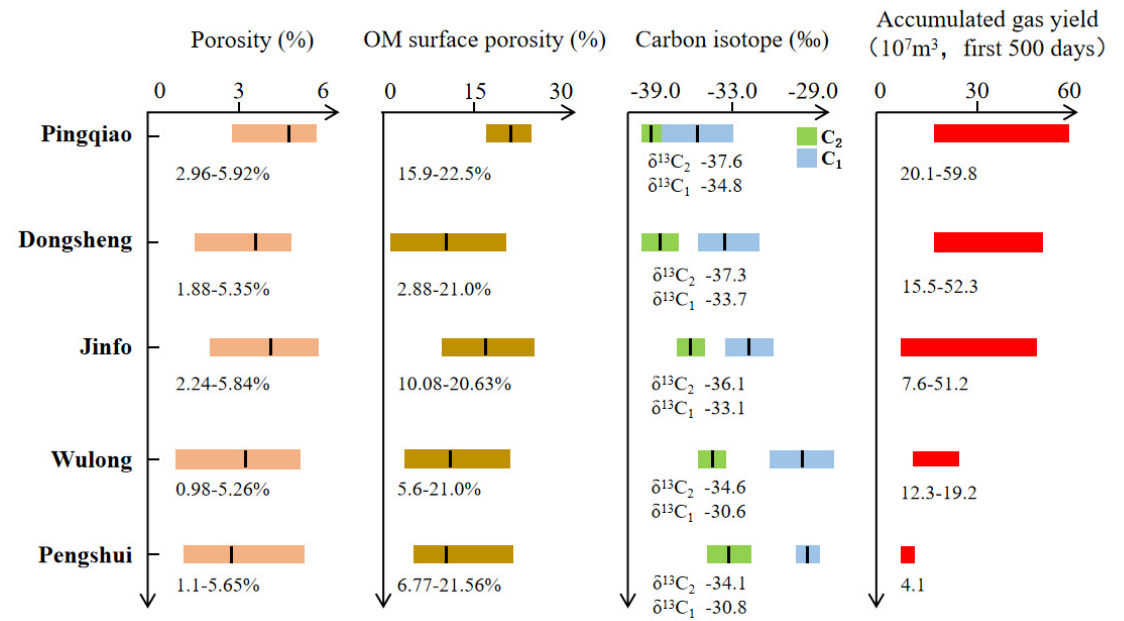
Figure 5. Distribution of porosity, OM (organic matter) surface porosity, carbon isotope ( δ 13 C), and accumulated gas yield for shale gas systems in the studied areas.